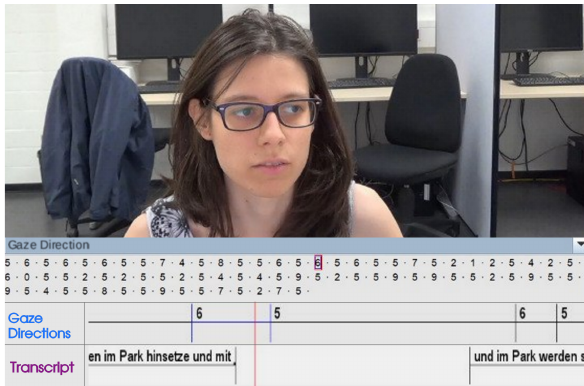
Figure 3. Modified screenshot of the annotated video and audio track of one participant in the software ELAN. At the top, the video can be seen. At the bottom, annotation tiers for the gaze direction and the transcription are shown. The participant’s eye gaze in the displayed moment was labeled ‘6’ as seen in the tier “Gaze Directions” (see also Fig. 1 a)). Between the video and the tiers, the sequence of all gaze directions annotated for this participant can be found. This is not to be confused with a scanpath, as it merely represents a temporal progression of